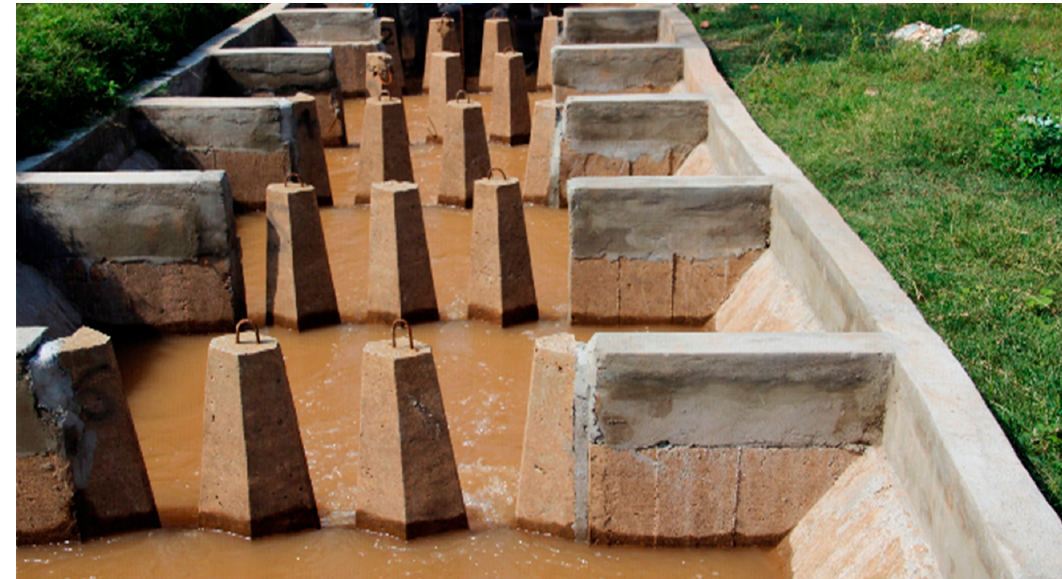
Figure 2. The cone fishway at Pak Peung village. The fishway had 1.0 m-high concrete cone baffles set up in two alternating arrangements—one with three full slots and the other with two full slots and two half slots (source: Lee Baumgartner). Each set of baffles was separated by a 2 m long by 3 m wide pool, which had a depth ranging from 0.6 to 1.5 m depending on the flow through the fishway. The sloping channel walls, low depth and low energy pools also made for safe human access and egress, which was a site-specific requirement in the remote village where children regularly interact with the fishway.